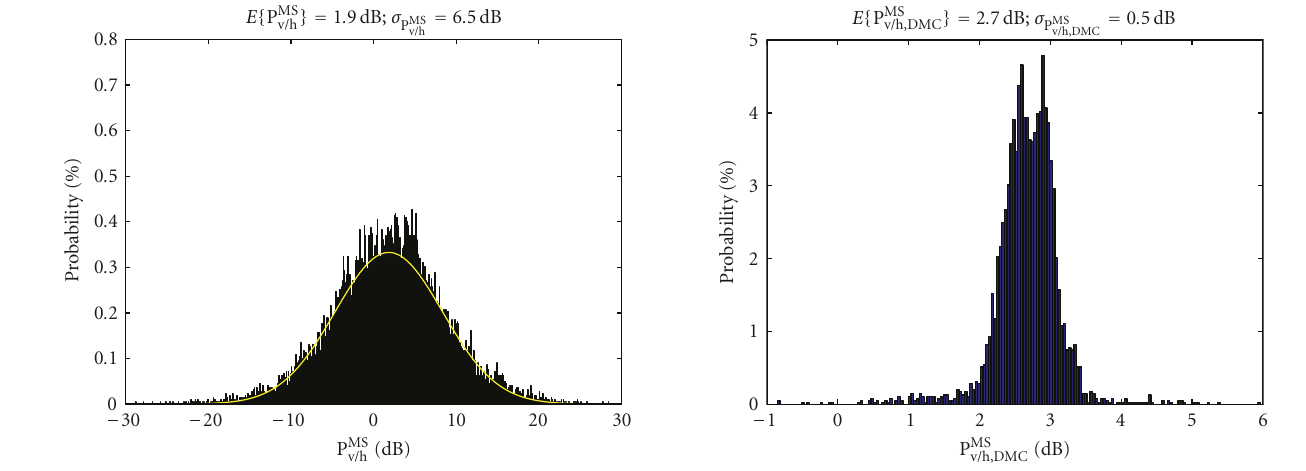
of the SCs, macrocell Rx19 to Rx27. v/h